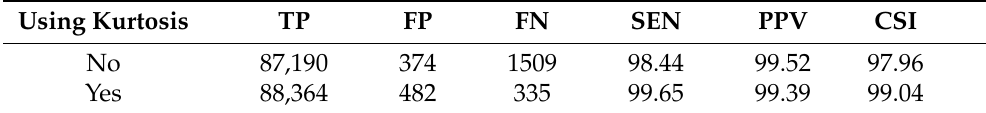
Table 5. The performance of the proposed method using a kurtosis threshold.